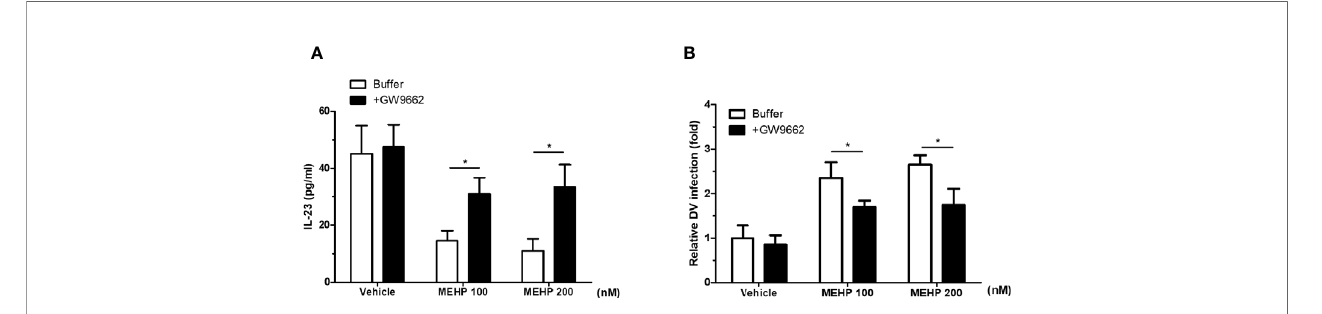
FIGURE 5 | PPAR g is involved in MEHP-induced IL-23 downregulation. (A) GW9662 signi fi cantly increased IL-23 levels in MEHP-treated monocyte-derived macrophages (MDMs). (C) GW9662 signi fi cantly decreased DV viral loads in MEHP-treated MDMs. *P < 0.05 by Kruskal-Wallis test; N = 6, means